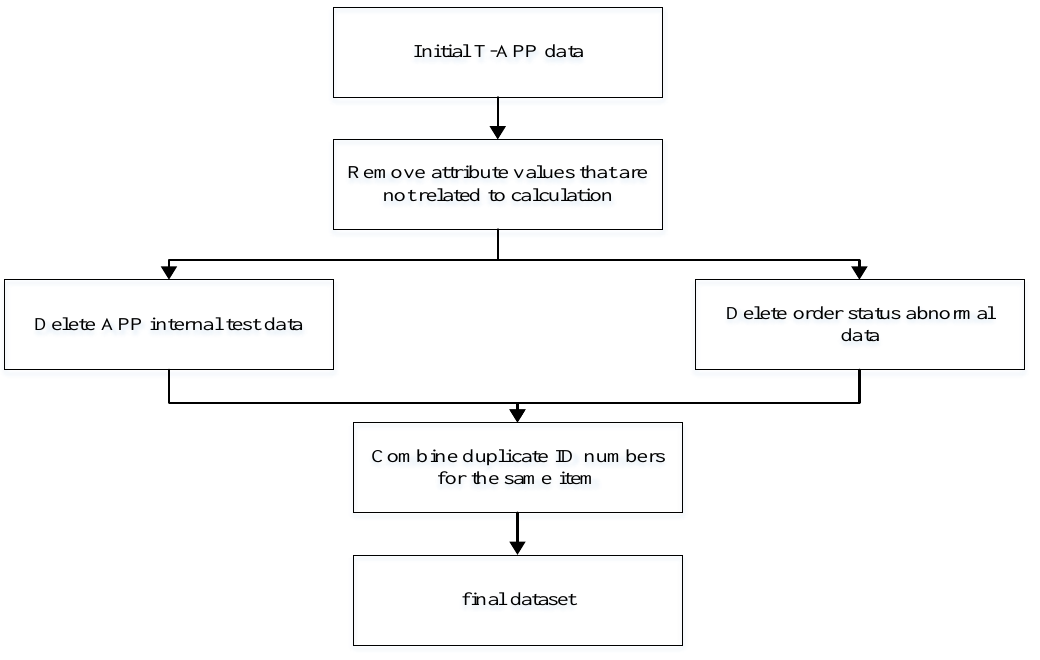
Figure 2. Data cleaning flow chart.